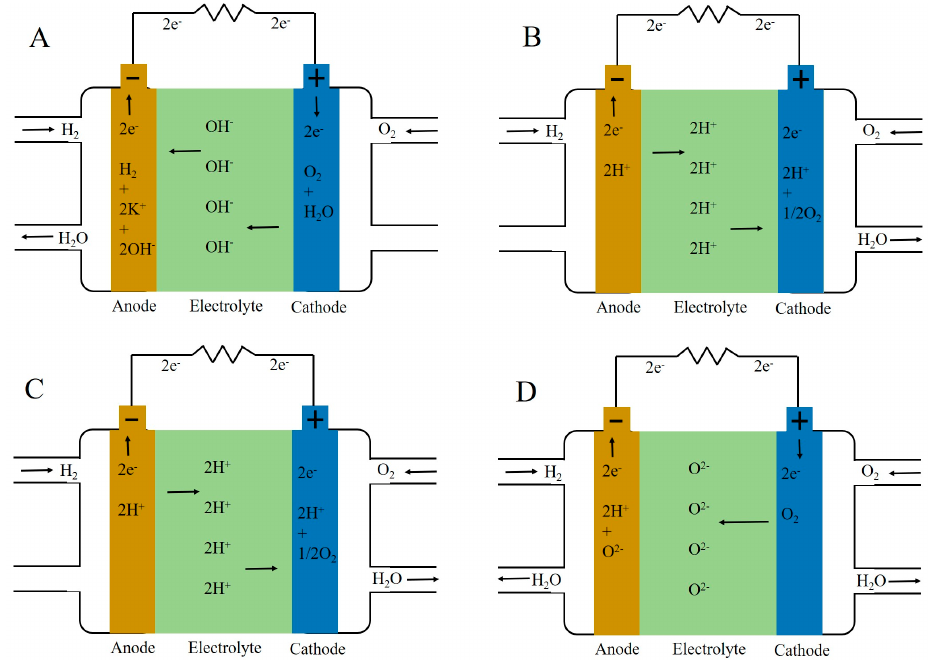
Figure 1. Principles of operation of an alkaline fuel cell ( A ), proton exchange membrane fuel cell ( B ), phosphoric acid fuel cell ( C ), and solid oxide fuel cell ( D ) [7]. phosphoric acid fuel cell ( C ), and solid oxide fuel cell ( D )